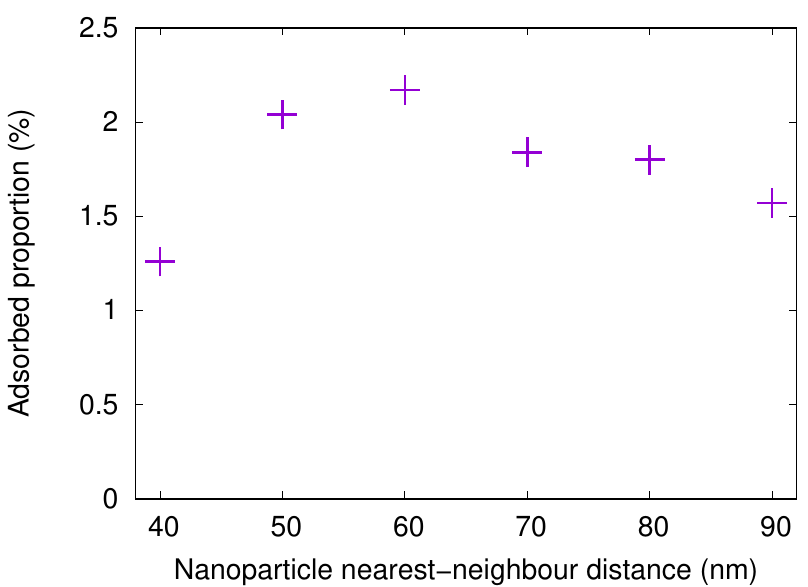
Figure 7. The adsorbed proportion of the fibrinogen main body in simulations with flat surfaces with attached nanoparticles (20 nm radius) with different distances between centers of nearest